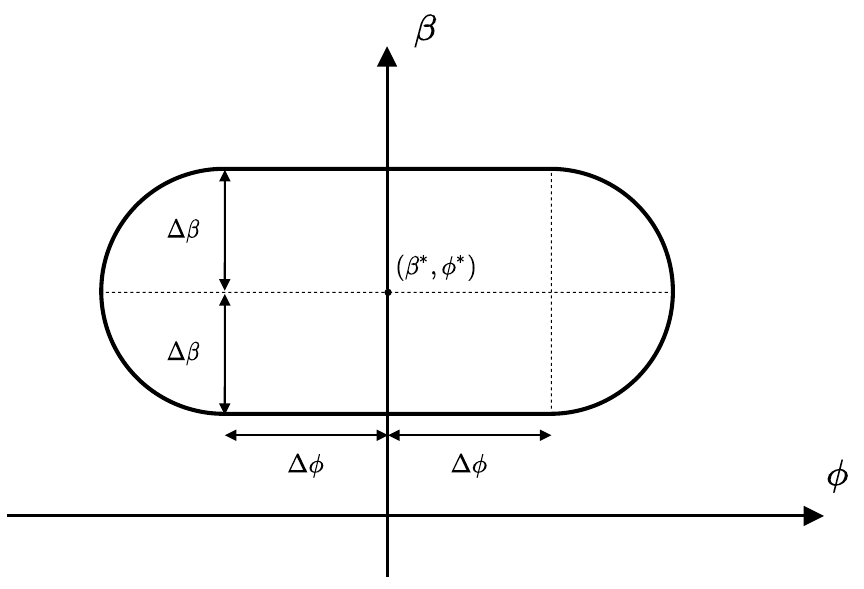
Figure 6. Kite path